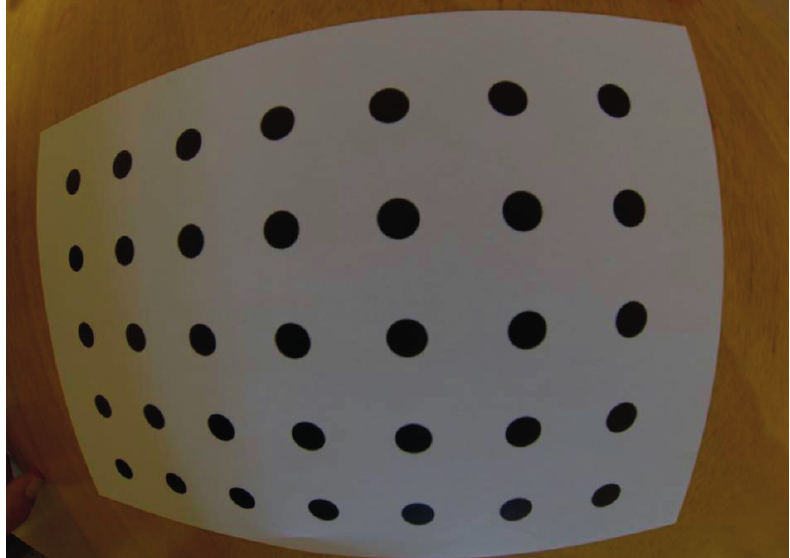
Figure 6. In case of wide angle lens cameras and when the inclination of the camera is big the circle’s diameter of the control points might be three times smaller at the edges of the calibration